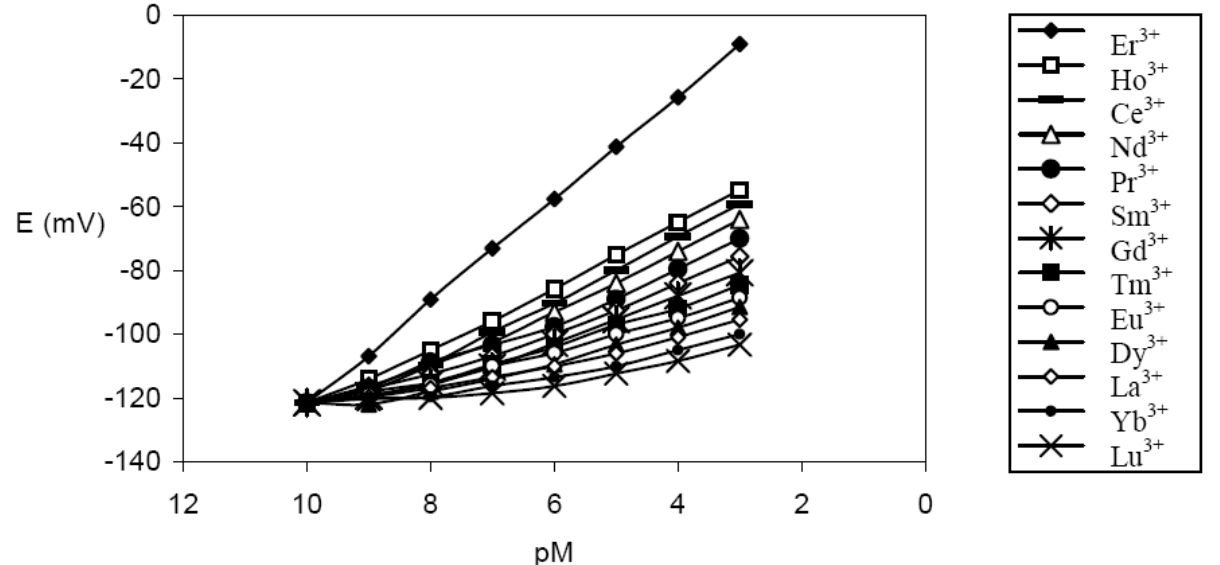
Figure 4. Potential response of lanthanide metal ion-selective microelectrode based on HDB with the composition of membrane no.